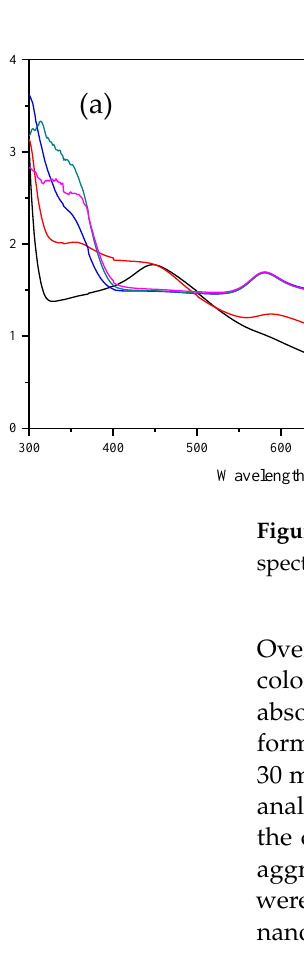
Figure 9. Color changes according to reaction times when synthesizing CuNPs.